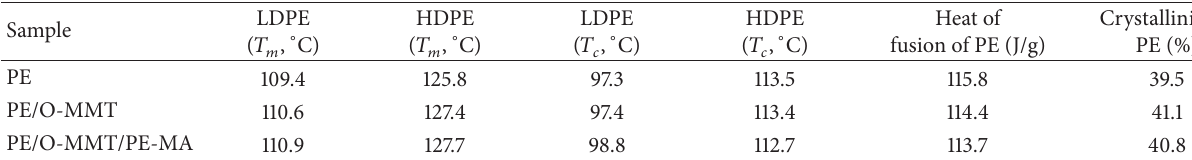
Table 2: DSC data for PE and its nanocomposites.